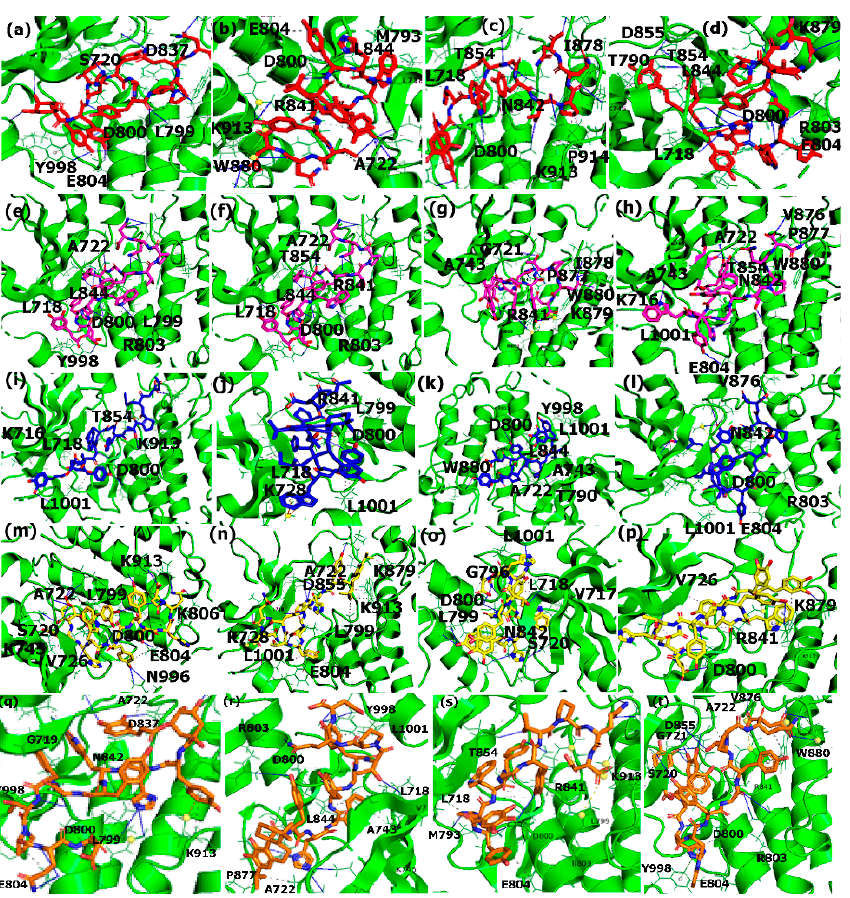
Figure 7. PLIP results for polyphenol peptide conjugates bound to EGFR ( a ) CGAPep ( b ) CSAPep ( c ) GLAPep ( d ) RMAPep ( e ) CGAMut1; ( f ) CSAMut1; ( g ) GLAMut1; ( h ) RMAMut1; ( i ) CGAMut2 ( j ) CSAMut2; ( k ) GLAMut2; ( l ) RMAMut2; ( m ) CGAMut3; ( n ) CSAMut3; ( o ) GLAMut3; ( p ) RMA- Mut3; ( q ) CGAMut4; ( r ) CSAMut4; ( s ) GLAMut4; ( t ) RMAMut4 .